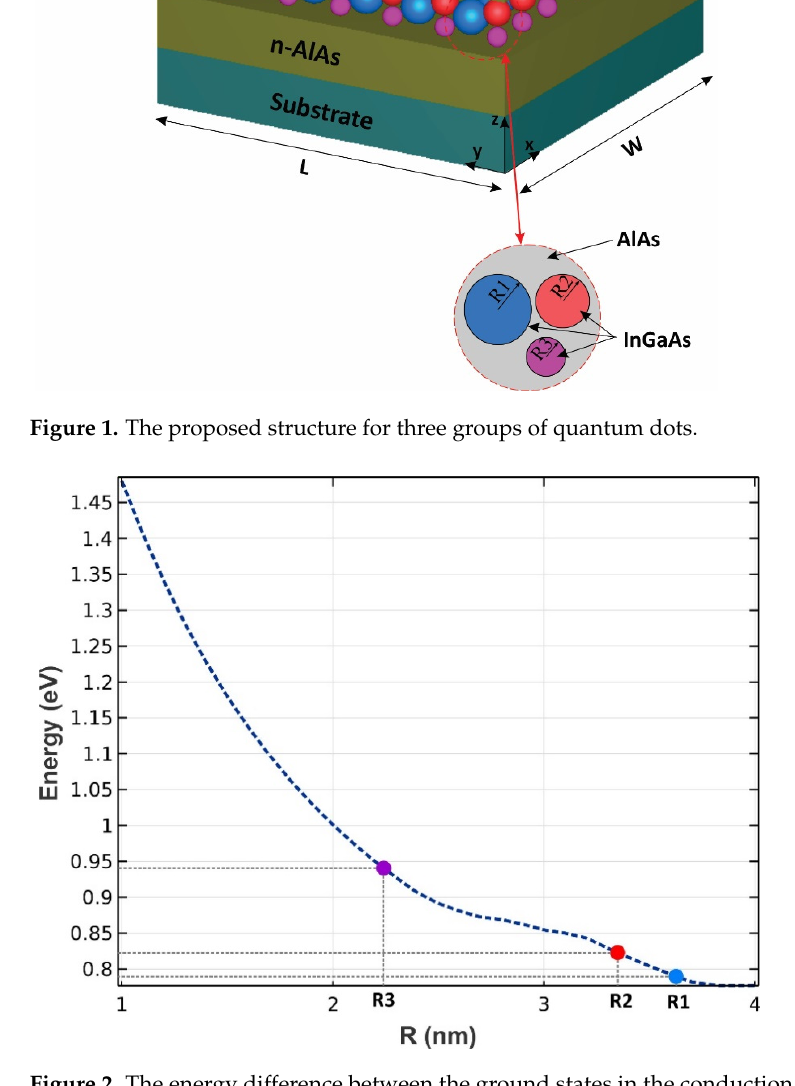
Figure 2. The energy difference between the ground states in the conduction band and the valence band (radiated energy) as a function of the QD’s radius. Three groups have been chosen (R1, R2, and R3).